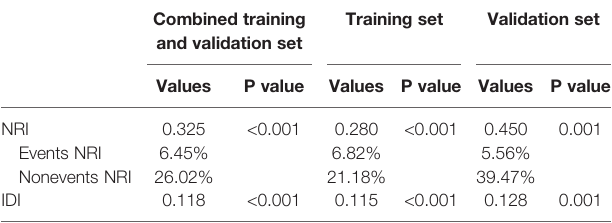
TABLE 3 | The NRI and IDI indices. Combined training Training set Validation and validation set